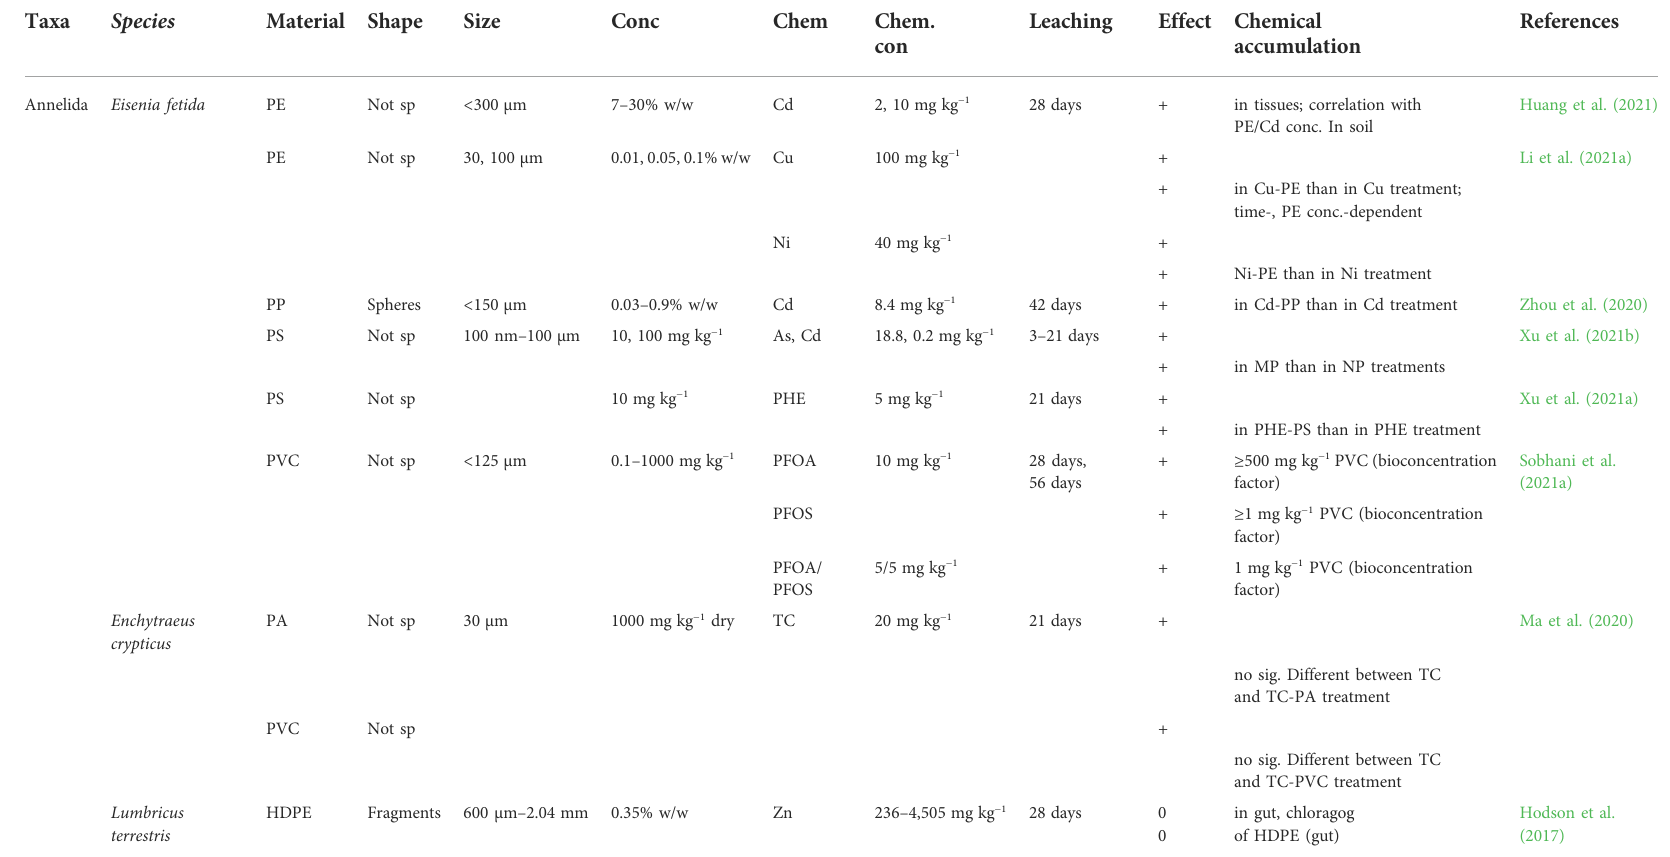
Abbreviations:MP=microplastic,NP=nanoplastic,notsp.=notspeci fi ed,PHE=phenanthrene,TC=tetracycline,d=days.Theconcentrations(conc.)oftheappliedmicroplasticarestatedfordrysoil.Alleffectsarestatedincomparisonwiththecontrol treatment unless stated otherwise. + = signi fi cant higher chemical accumulation. . ., 0 = no chemical accumulation. .